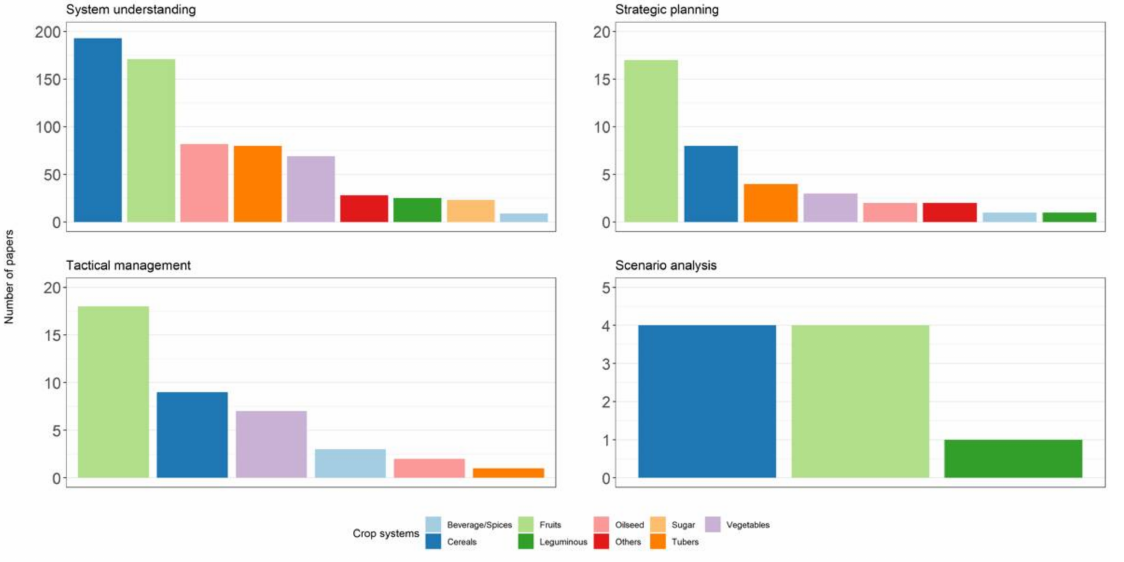
Figure 6. Number of papers for each scope of disease models and for each crop group. Scopes are described in Table